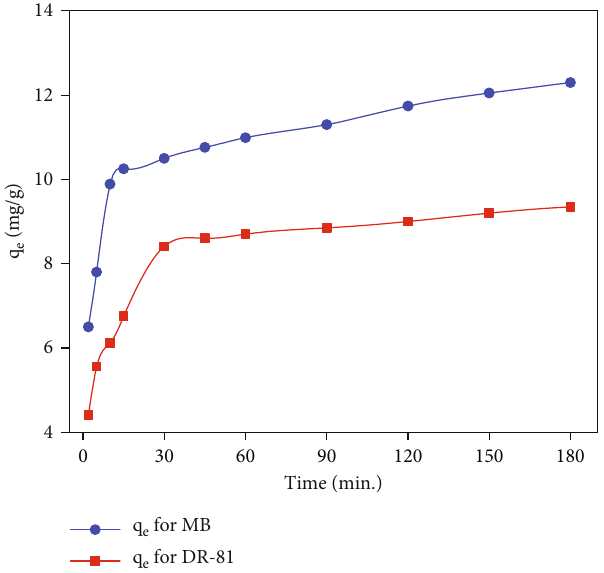
Figure 8: E ff ect of contact time on the adsorption capacity of the synthesized Zn-adeninate bio-MOF for the MB and DR-81 dyes ( pH = 7 , bio-MOF dosage = 1 gL − 1 , initial concentration = 10 ppm, solution temperature = 23 ° C, and stirring speed = 300